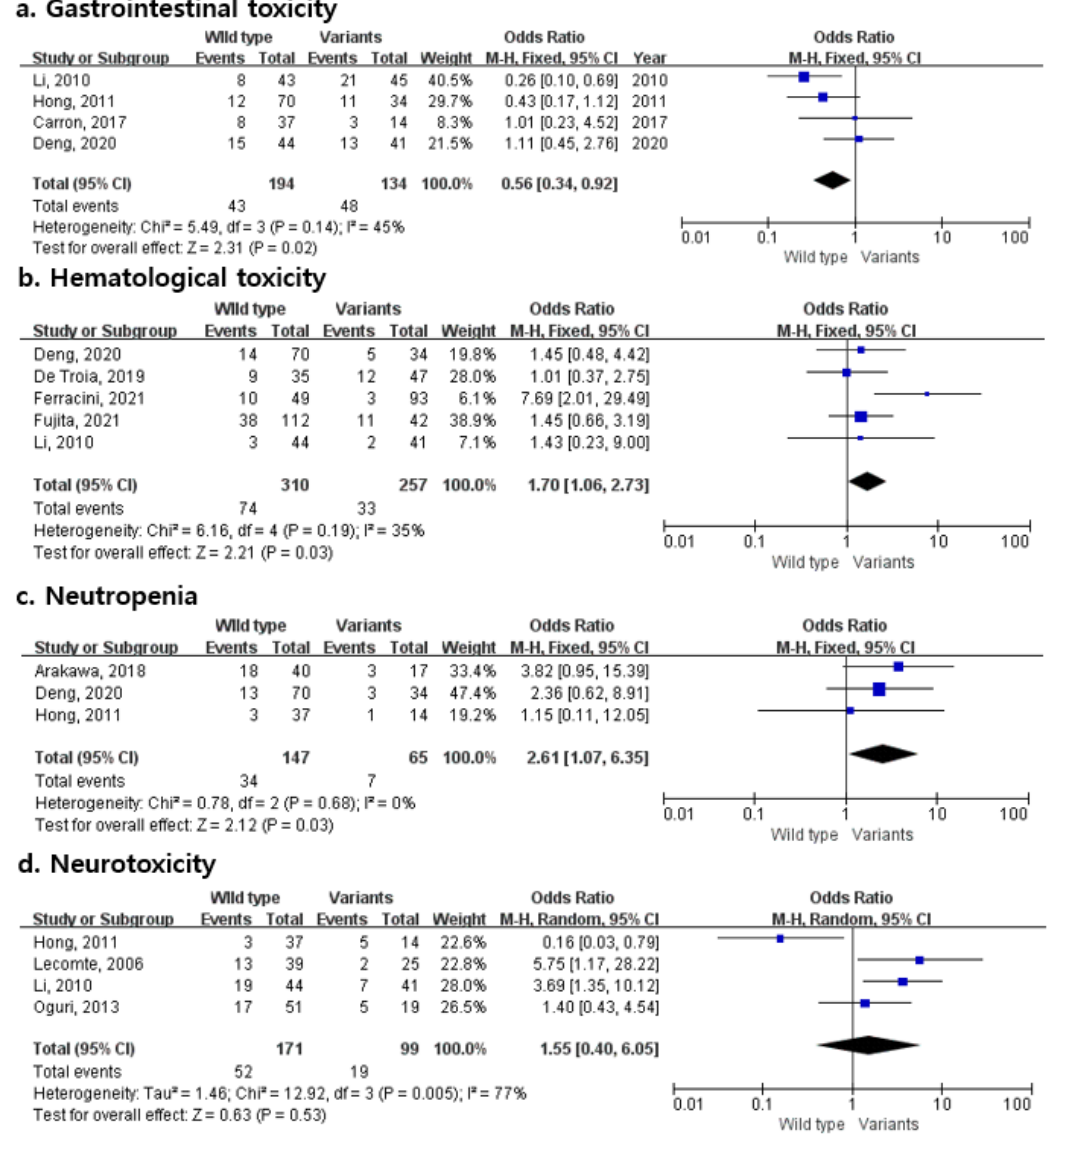
Figure 2. Forest plots of the association between platinum-induced toxicities and GSTP1 polymor- phism ( a ) gastrointestinal toxicity; ( b ) hematological toxicity; ( c ) neutropenia; ( d ) neurotoxicity.